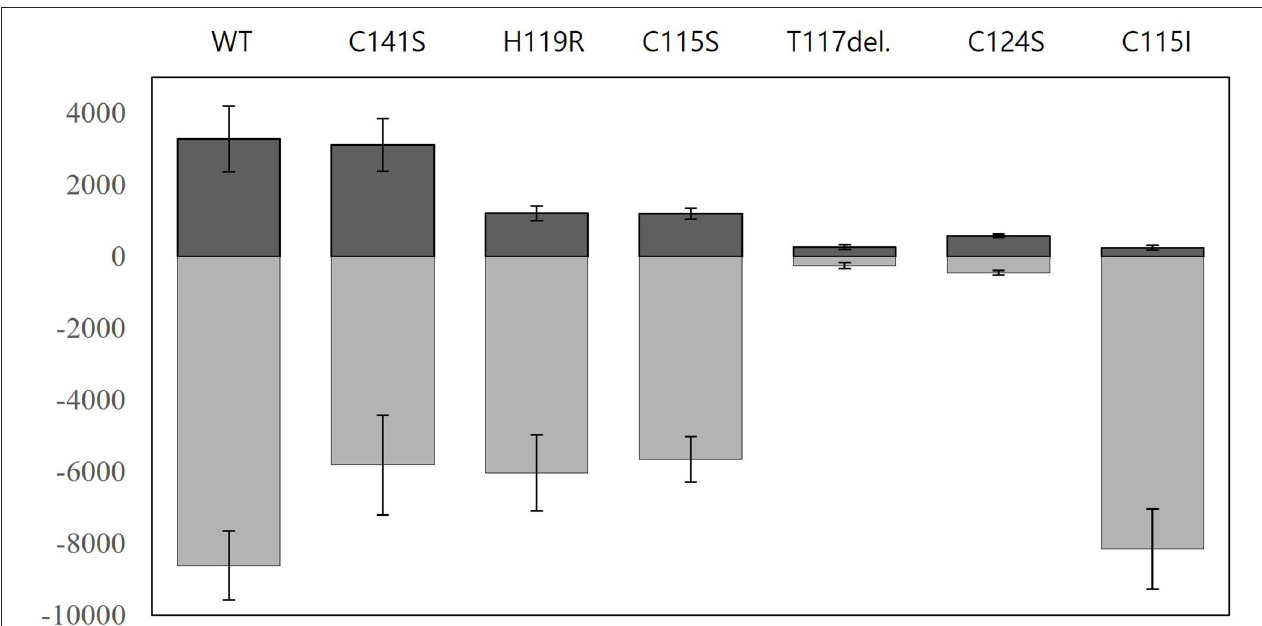
FIGURE 6 | Nascent fluorescence signals of biosensors employing ZntR WT and mutants. The fluorescence intensities of biosensors based on E. coli-zntR/copA/zntA harboring pZntA-eGFP and ZntRs were measured after 2h exposures to 0 µ M and 1 µ M of Pb(II). Positive (dark gray) and negative (light gray) values indicate the arbitrary units of eGFPs induced by non-exposure and exposure, respectively. The experiments were replicated more than three times and the standard deviations were indicated as error